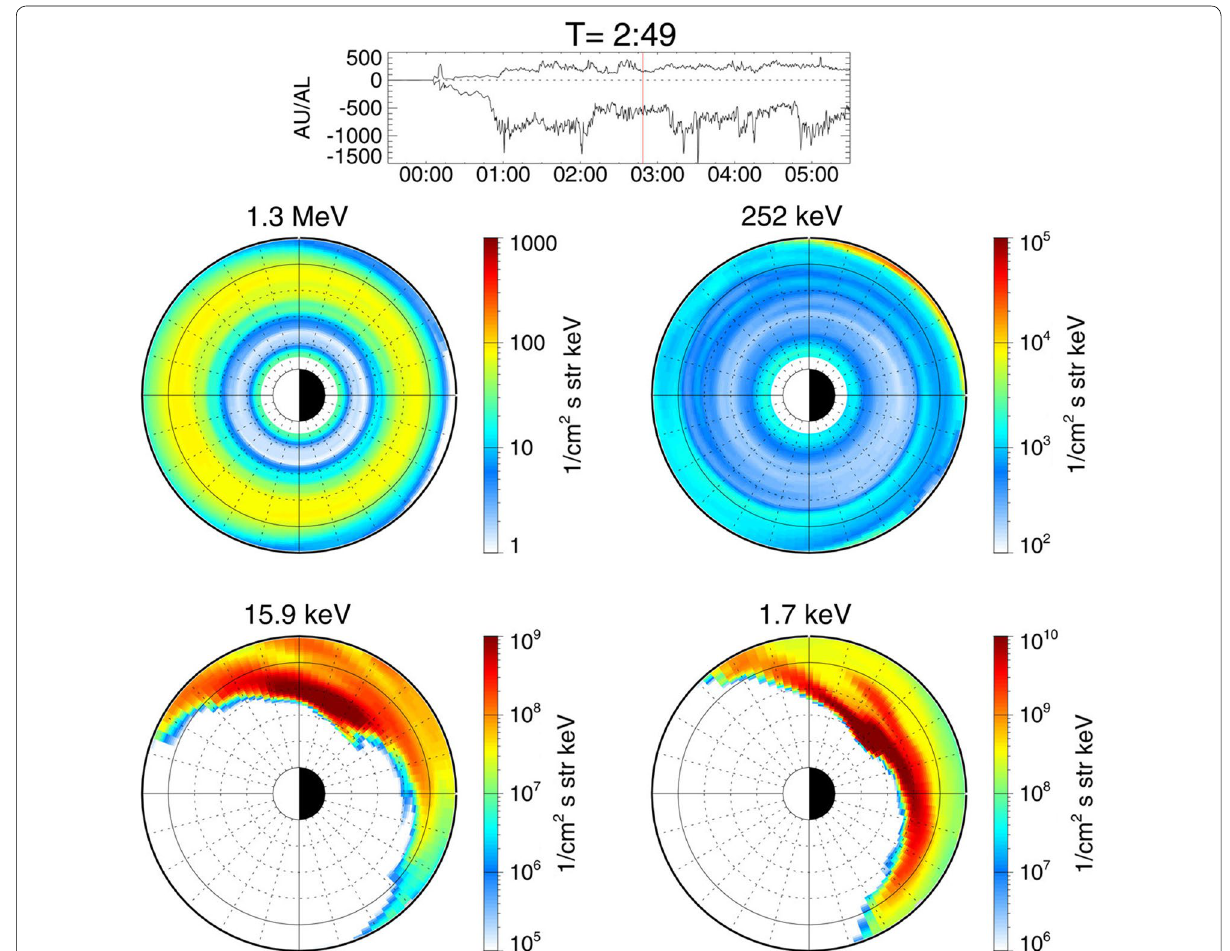
Fig. 3 Differential flux of electrons with equatorial pitch angle of 90° with kinetic energy of 1.3 MeV, 252.0, 15.9 and 1.7 keV at T The Sun is to the left. The outer circle corresponds to the geocentric distance of 6 Re. In the top panel, the calculated AU/AL indices are